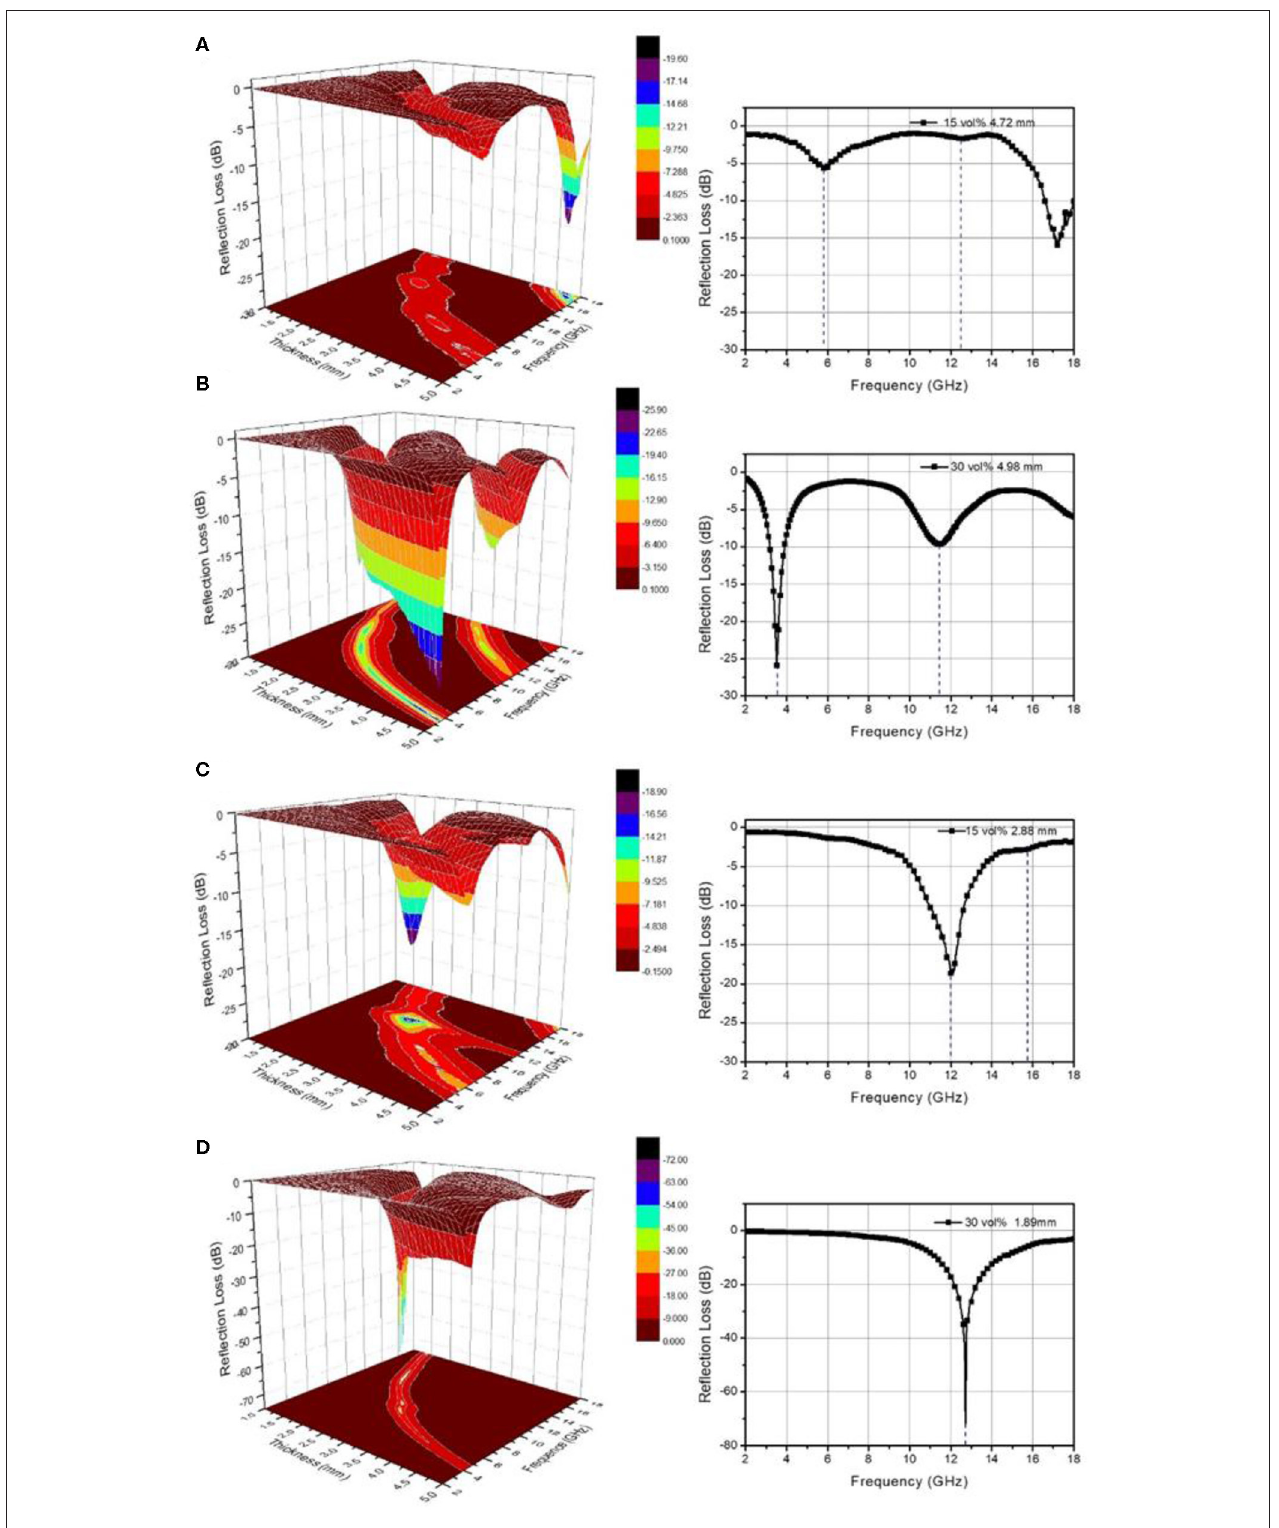
FIGURE 4 | Frequency dependence of 3D plots and the optimal reflection loss (RL min ) curve of WC-1 (A,B) and WC-2 (C,D) .